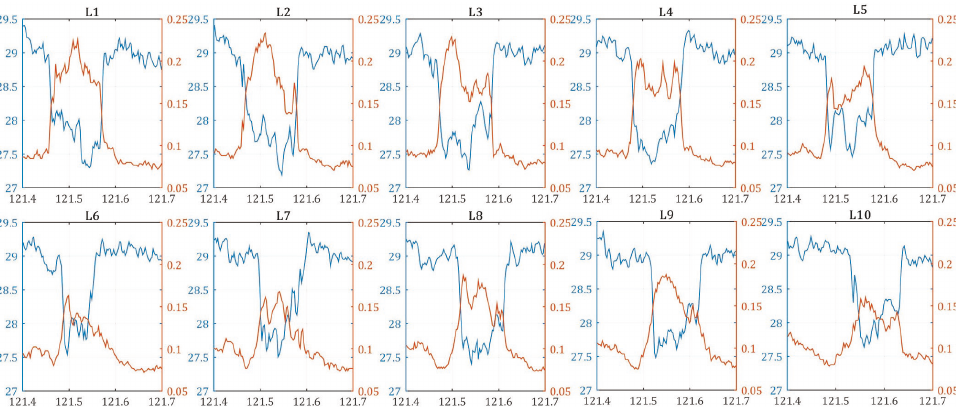
Figure 4. SST and chlorophyll-a (Chl-a) of L1 to L10 in Figure 3e.